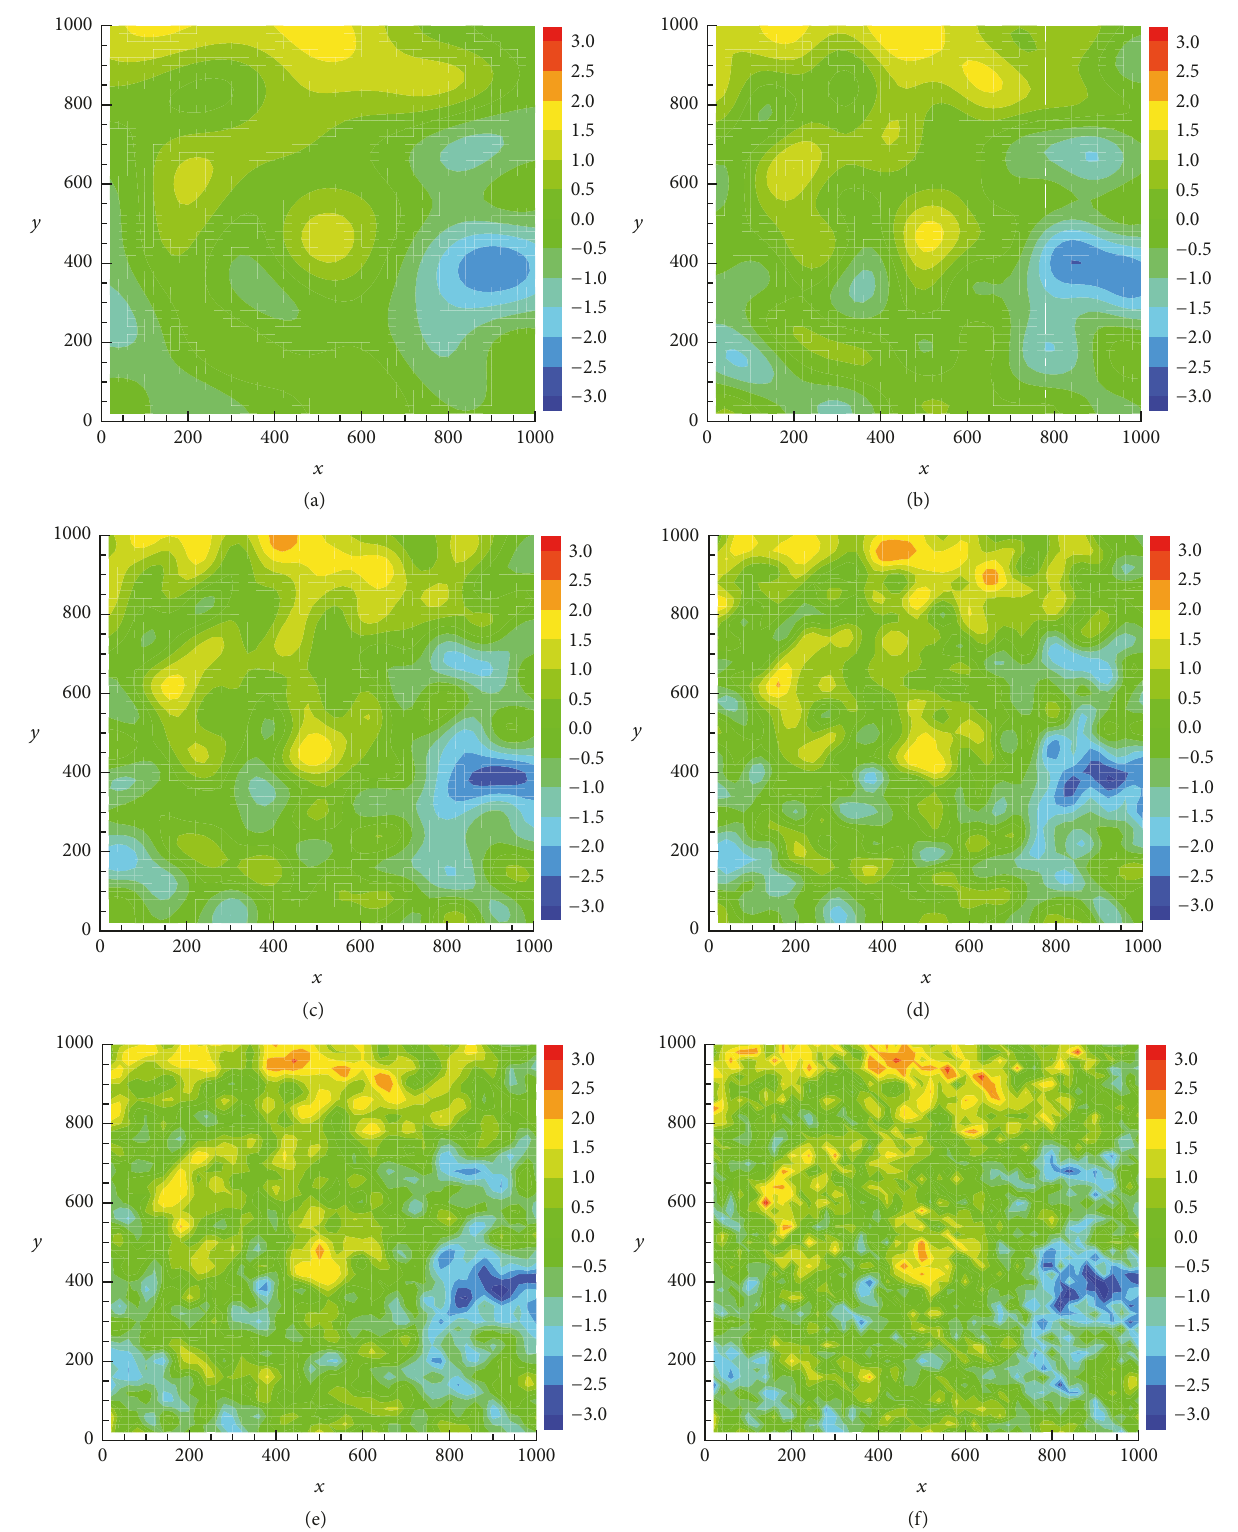
Figure 6: Generated multiscale random fractal field with different numbers of retained terms in KL expansion: (a) 50; (b) 100; (c) 200; (d) 500; (e) 1000; (f)